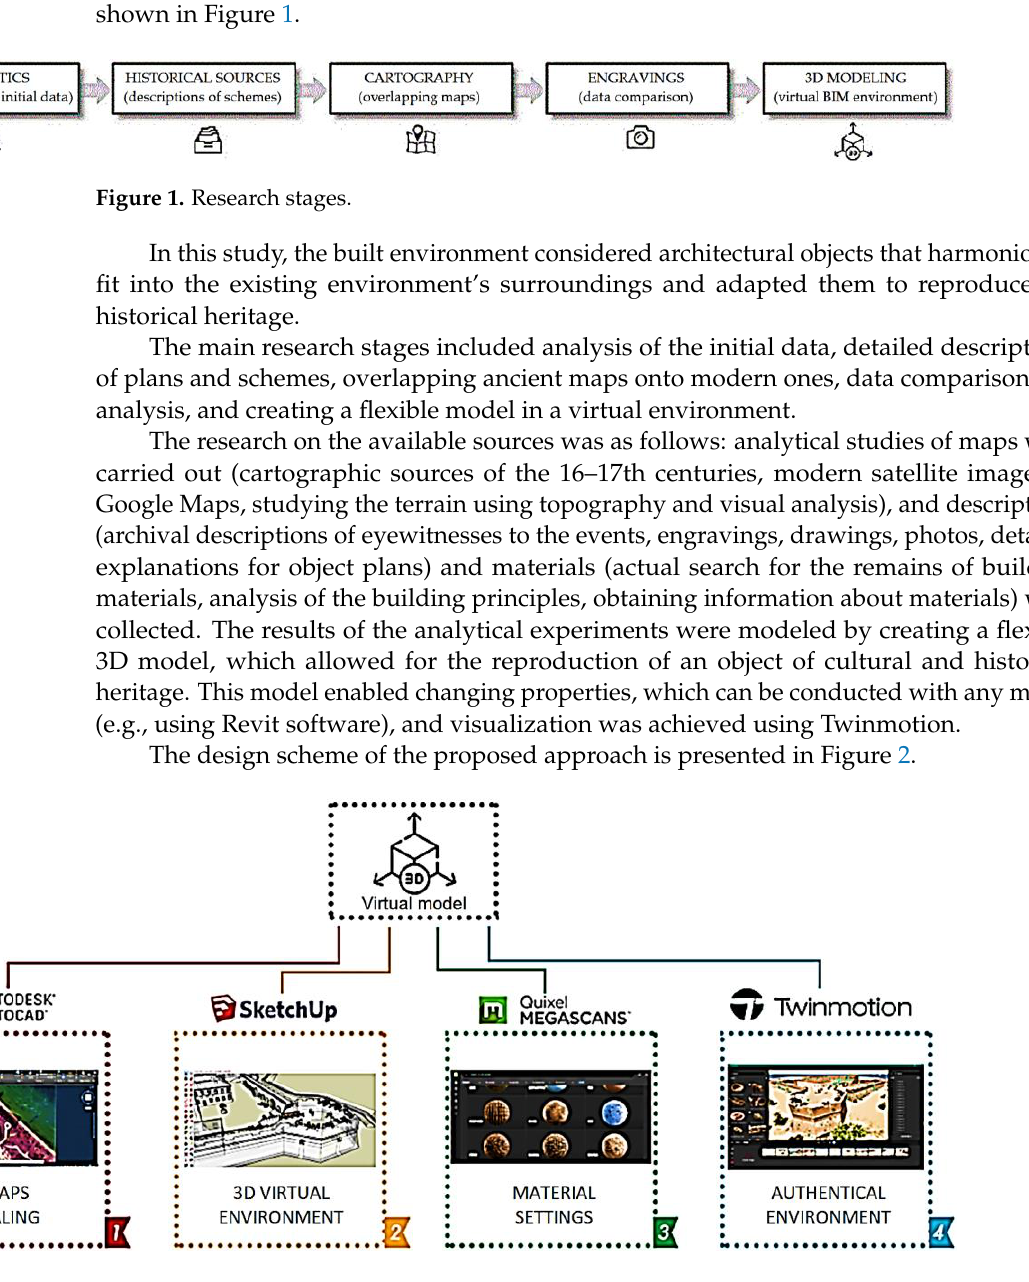
Figure 2. The design scheme of the applied approach.